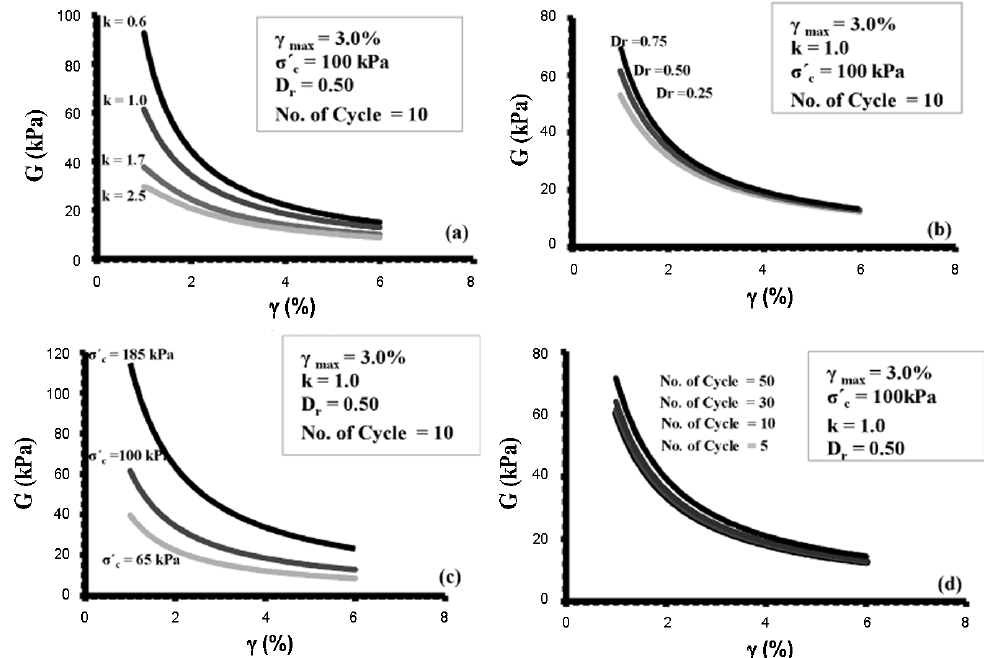
Fig. 13. Shear modulus versus shear